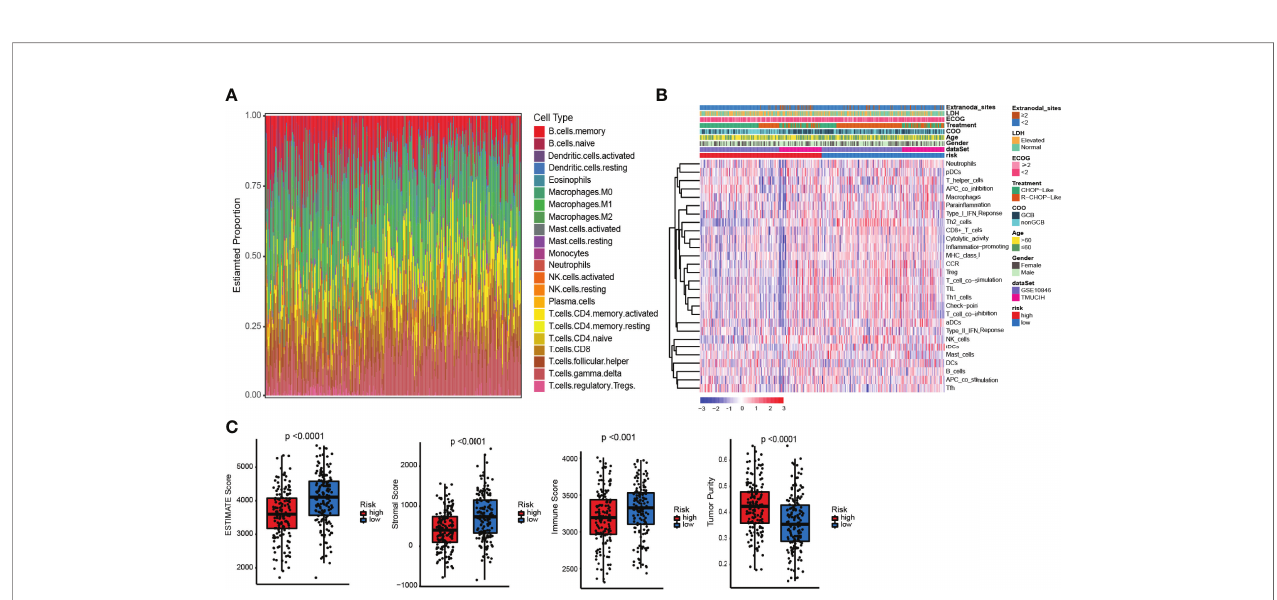
FIGURE 5 | Differences in immune in fi ltration between the high- and low-risk ELncSig groups. (A) The composition of immune cells assessed by the Cell Type Identi fi cation by Estimating Relative Subsets of RNA Transcripts (CIBERSORT) algorithm in the training cohort. (B) Heatmap showing the relative abundances of 28 in fi ltrating immune cell subpopulations between the high- and low-risk ELncSig groups according to single-sample gene set enrichment analysis (ssGSEA). (C) The ESTIMATE score, stromal score, immune score, and tumor purity of EC1 and EC2 according to the CIBERSORT